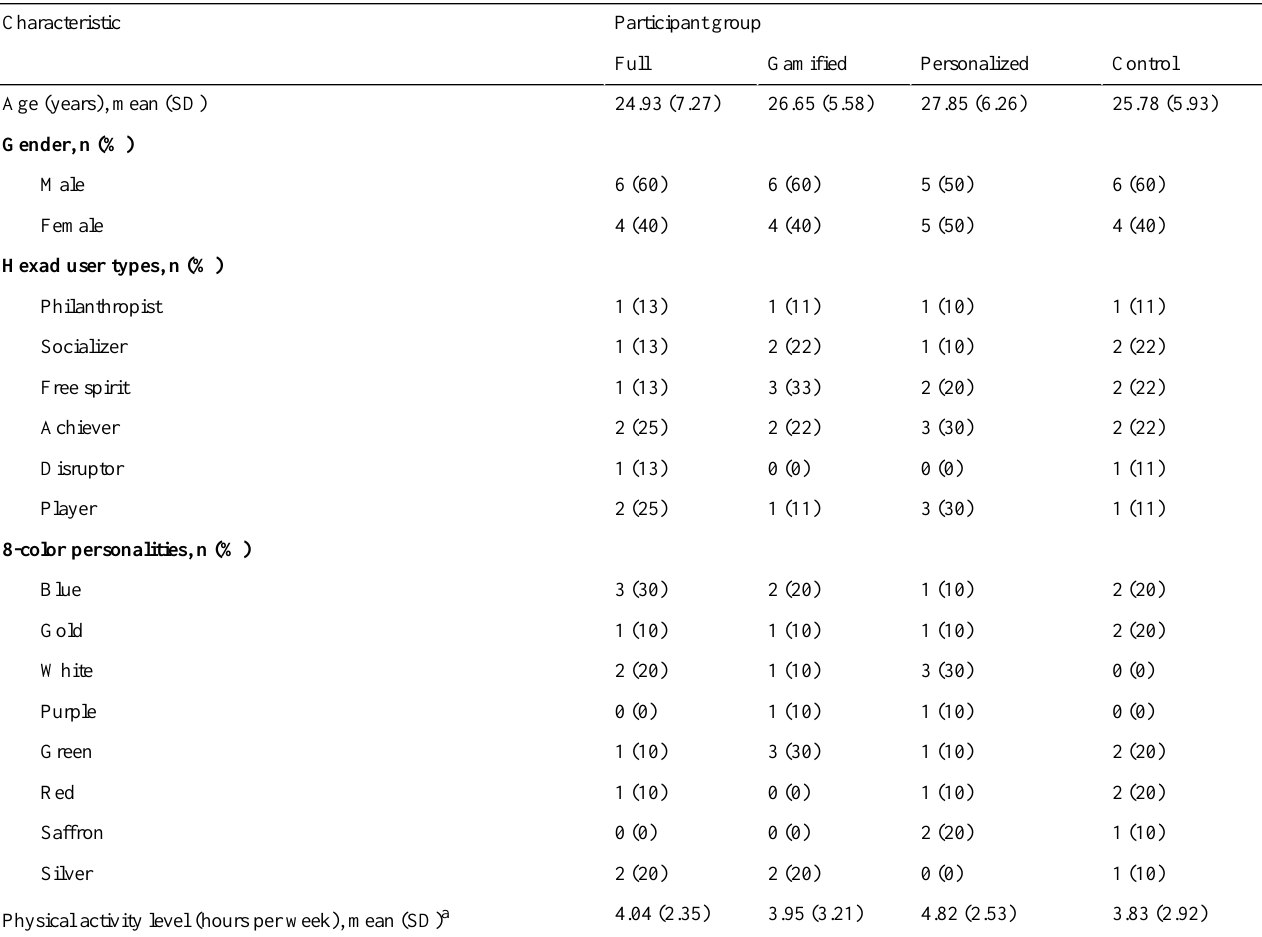
Table 3. Demographical data for the 4 participant groups (N=40).